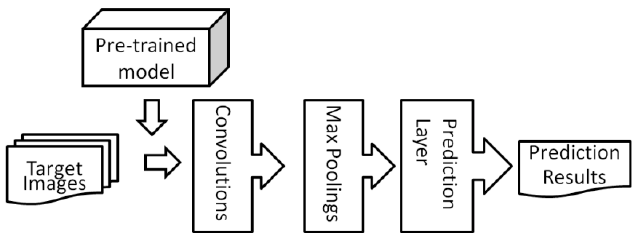
Figure 7. Layer transfer-based transfer learning.